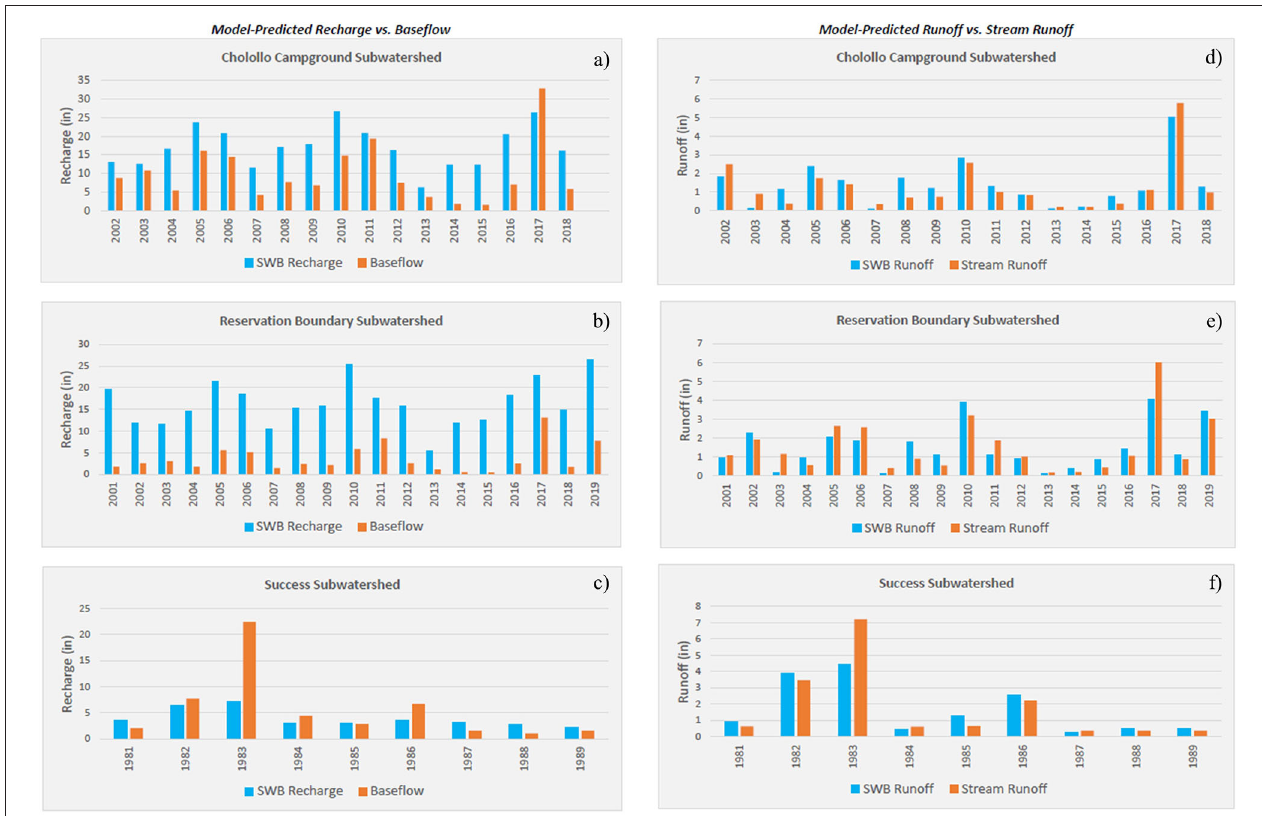
FIGURE 5 | Bar charts of SWB-predicted recharge vs. baseflow ( a,b Hagedorn, 2020; c HYSEP sliding-interval); bar charts of SWB-predicted runoff vs. stream runoff ( d,e Hagedorn, 2020; f HYSEP sliding-interval).